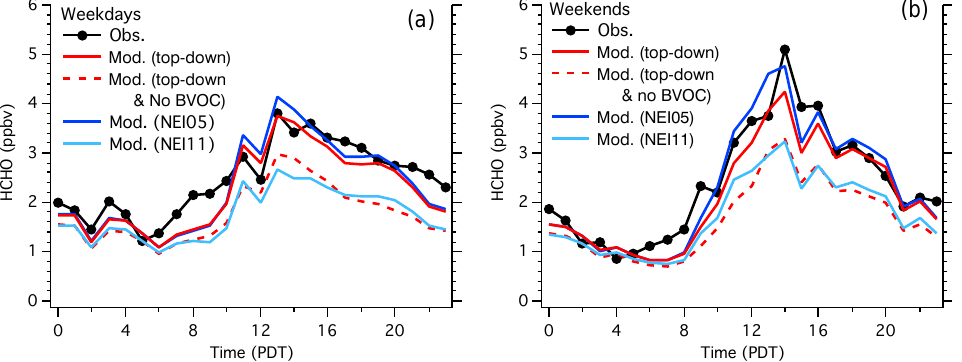
Figure 1. Diurnal variations of ground-based observations (black filled circles with solid lines) of HCHO and the corresponding model simulations (lines without symbols) in Pasadena (34.1370 ◦ N, 118.1254 ◦ W) averaged for weekdays (a) and weekends (b) during May–June 2010. All model simulations utilized the fuel-based NO x and CO emissions in Kim et al. (2016). The red solid line shows the results utilizing the VOC emissions from the top-down approach in Borbon et al. (2013), the red dashed line denotes the same model settings represented by the red solid line (top-down approach) except for zero biogenic VOC (BVOC) emissions, the blue solid line represents the model results using the VOC emissions from NEI05 (as in Kim et al., 2016), and the light blue line shows the model output using the VOC emissions from